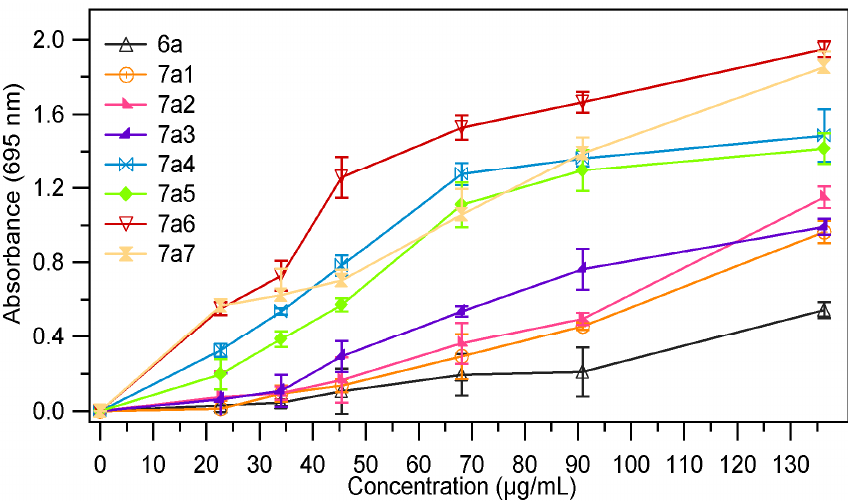
in ref. to 6a . 1–7